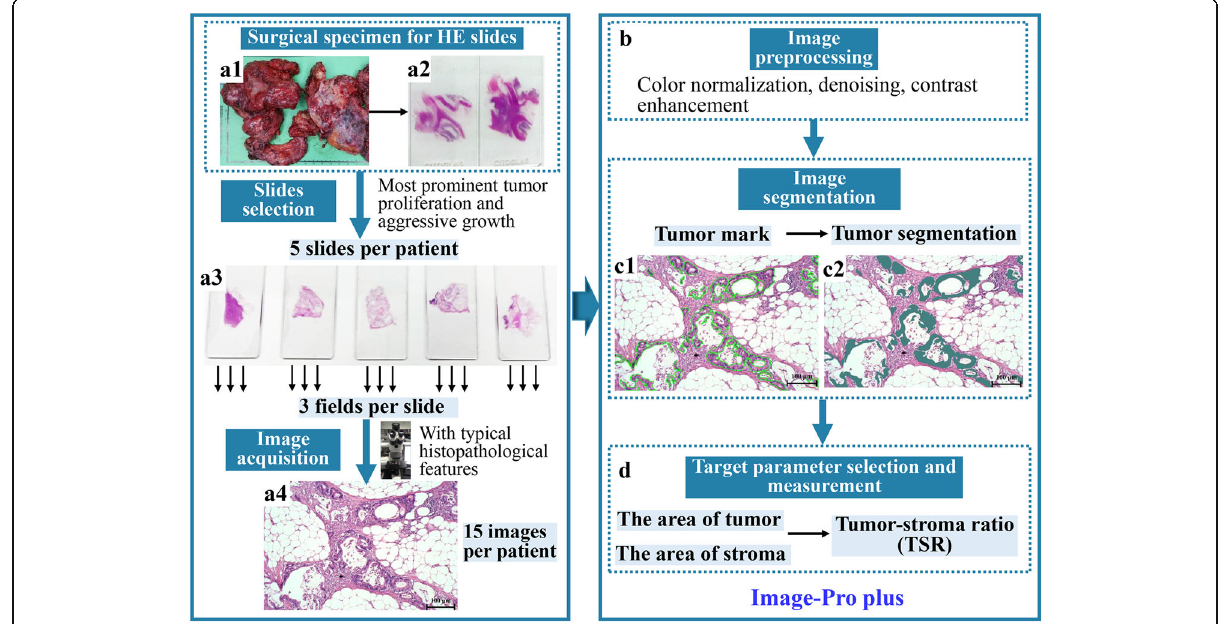
Fig. 1 The workflow of histopathological quantitative analysis. A1-2 Surgical specimen of PMP for HE staining slides; A3 5 HE stained slides with most prominent tumor proliferation and aggressive growth; A4 Pathological image with typical histopathological features of PMP (HE staining, ×100); C1-2 Tumor and stroma were segmented by Image-Pro Plus (HE staining, ×100). PMP: Pseudomyxoma peritonei; HE: Hematoxylin and eosin; TSR: Tumor-stroma